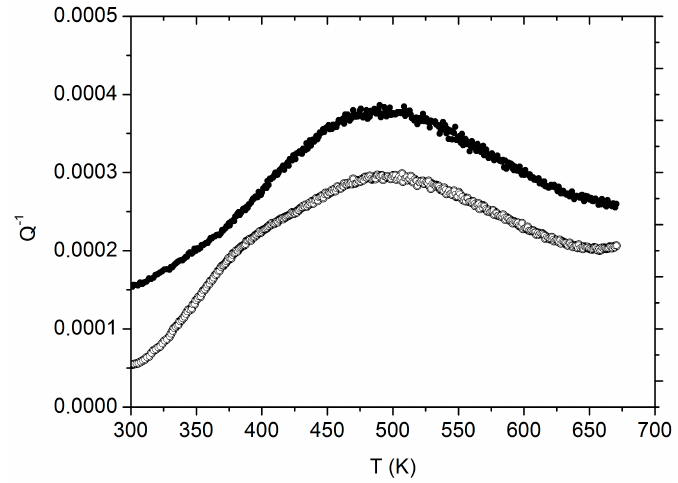
Figure 2. Q − 1 vs. temperature curves of films deposited on a silicon substrate with thicknesses of 0.2 µm (open symbols) and 1 µm (solid symbols).